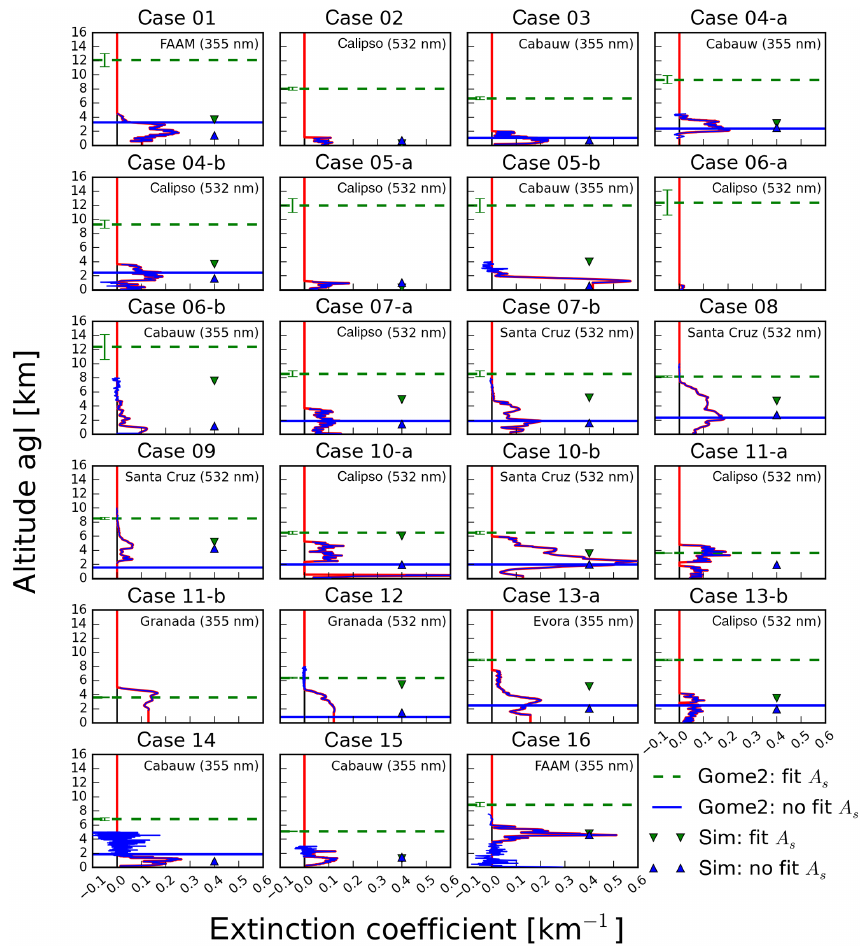
Figure 14. Comparison of retrieved aerosol layer mid heights for the 16 GOME-2A target pixels with aerosol extinction profiles measured by the lidars listed in Table 5. For some target pixels, two lidar measurements are included in the comparison. An overview of the spatial layout of target pixels and locations of the lidar observations is depicted in Fig. 5. Aerosol extinction profiles are given at 355 or 532nm for altitudes above ground level (a.g.l.). Profiles indicated with thin blue lines are the data provided by the lidar teams; profiles indicated with thick red lines are inter- and extrapolated and smoothed profiles used in the retrieval simulations. Horizontal lines are GOME-2A retrieved aerosol layer mid altitudes (green dashed: surface albedo is fitted; blue solid: surface albedo is fixed in retrieval). The retrieval setup is the same as in the scene retrievals of Sect. 7. Missing lines indicate that the GOME-2A retrieval did not converge. Finally, triangles indicate retrieved aerosol layer mid altitudes when the aerosol extinction profiles shown in red are used to simulate a measurement (green downward triangles: surface albedo is fitted; blue upward triangles: surface albedo is fixed in retrieval). Missing data points indicate that the simulated retrieval did not converge. For details of this simulation, see the main